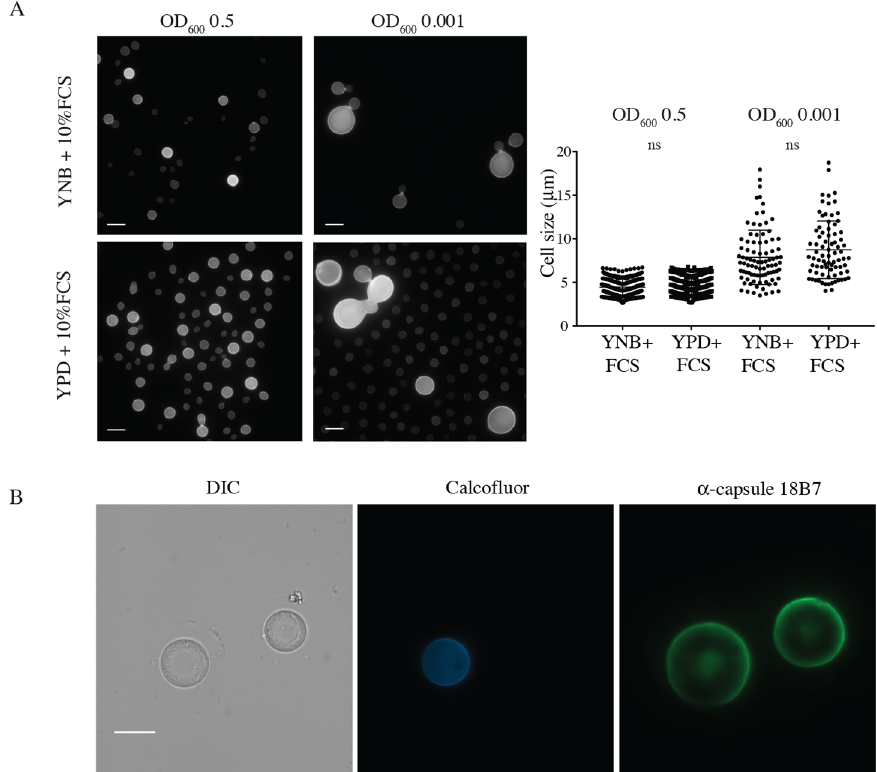
Fig 4. Titan cells are primed by YNB and can be maintained in 10%FCS. A) H99 cells pre-cultured in either YPD or YNB were washed 6 times in 1xPBS and then inoculated at the indicated OD in 10% FCS (3 days, 37˚C, 5%CO 2 ). Representative micrographs and cell size quantification are shown. B) Titan cells were induced for 24 hr, enriched for cells > 11 μ m, and stained with CFW (10 μ g/ml), then returned to inducing conditions for 48 hr. Representative micrographs show CFW (chitin) and mAb 18B7-labeled capsule. Scale bar = 10 μ